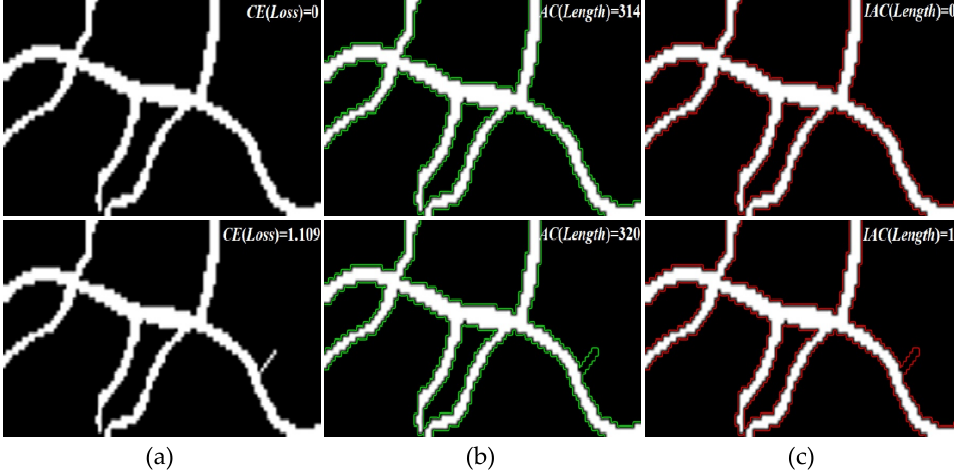
Figure 3. Comparison example of boundary contour segmentation. ( a ) CE-Loss; ( b ) AC-Loss; ( c ) IAC-Loss.